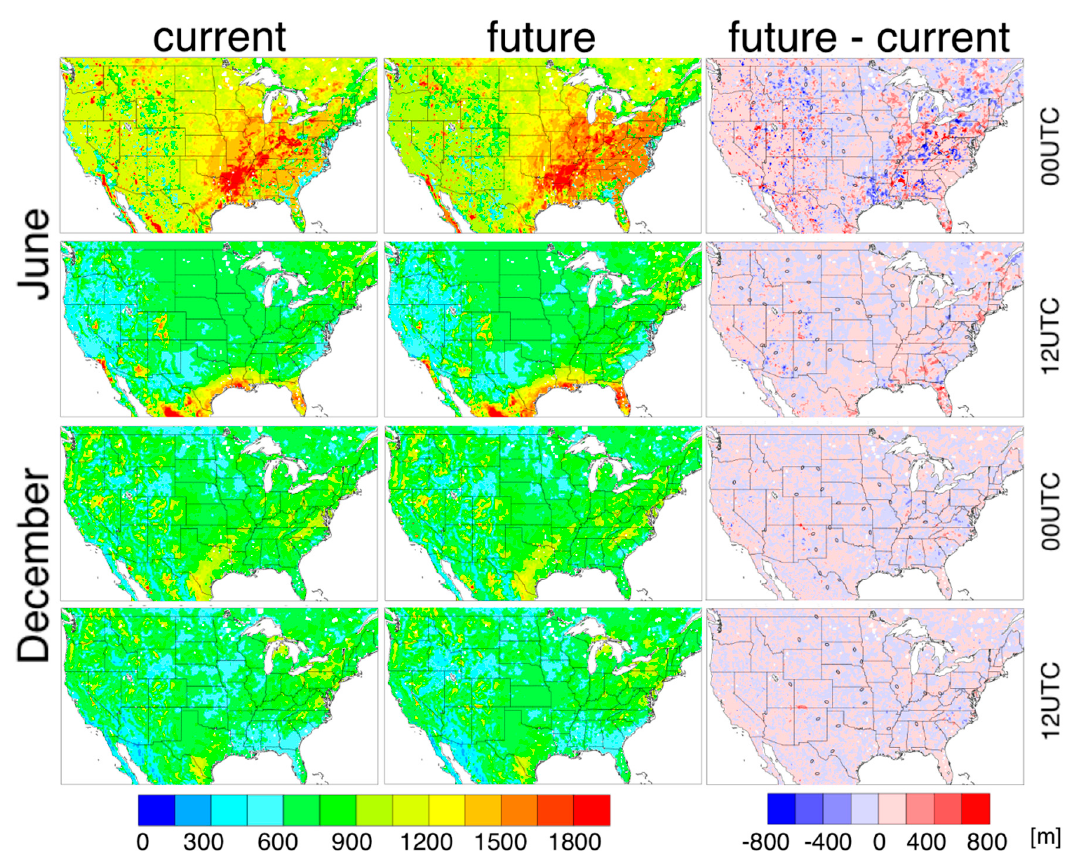
Figure 5. Simulated elevation of the maximum jet speed for the months of June and December at 00UTC (day) and 12UTC (night) under the current and future LULC conditions and their differences.